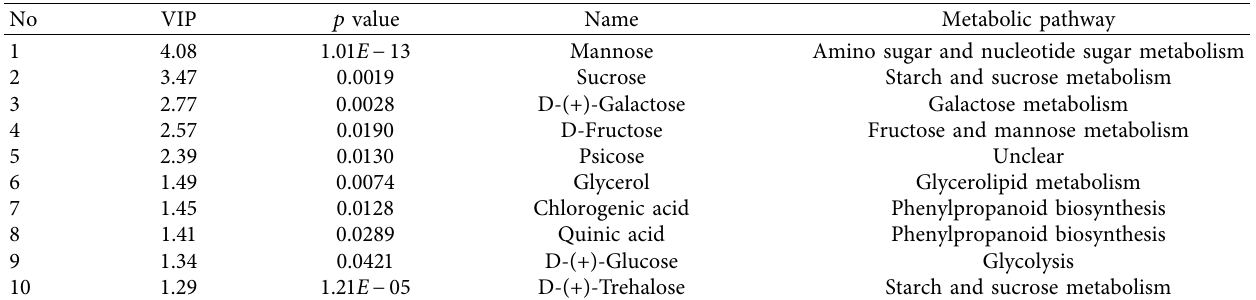
Table 2: Potential biomarkers of LJ in comparison to